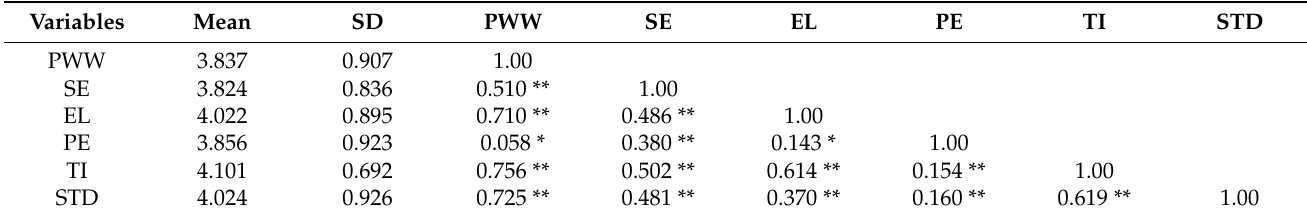
Table 4. Descriptive and correlational analysis.